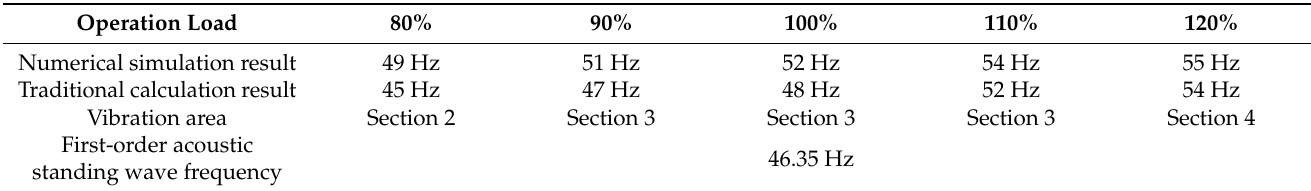
Table 5. The Karmen vortex frequency’s calculation results of 100 t/h D-type boilers in different conditions with different calculation